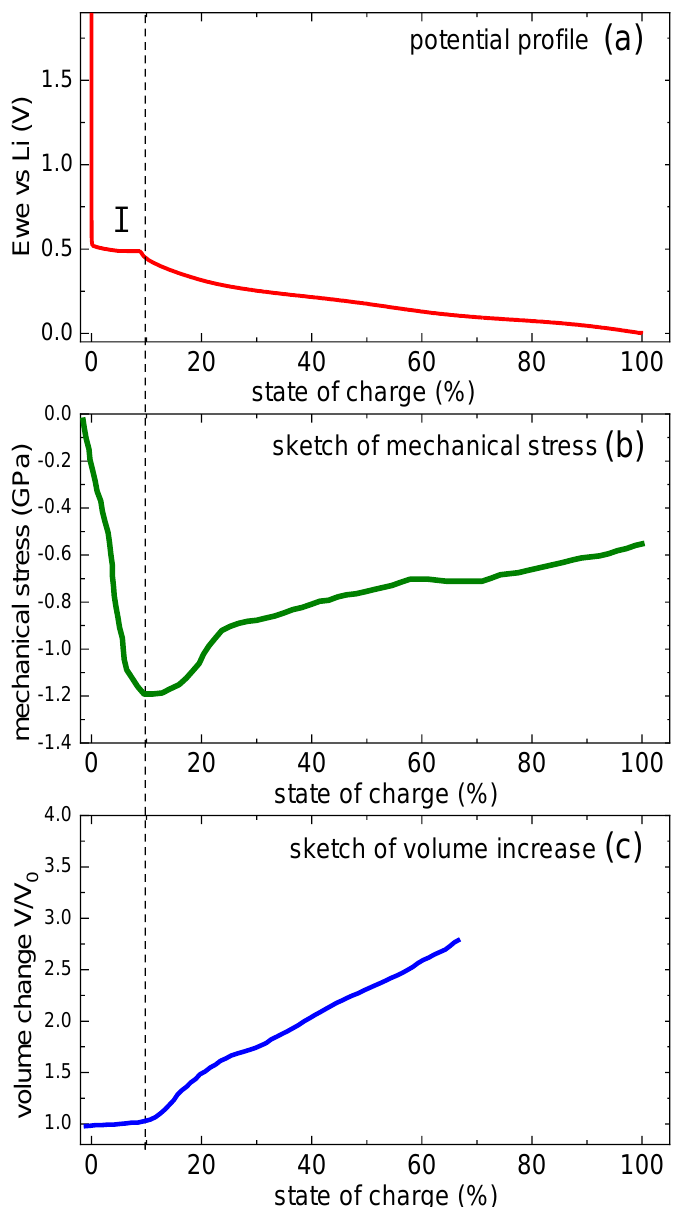
Figure 3. ( a ) Potential profile during the initial lithiation of an a-Si thin film of 230 nm in direct comparison with outlines (sketches) of ( b ) a typical mechanical stress curve during the lithiation of an a-Si film, and of ( c ) the typical volume increase curve during the lithiation of an a-Si film. All the values are plotted versus state of charge (SOC). 100% SOC corresponds to Li 3.75 Si (x = 3.75). V 0 represents the silicon film volume before lithiation. The dashed line represents the end of the predominant Li + uptake marked with roman number I in Figures 2 and 3a.